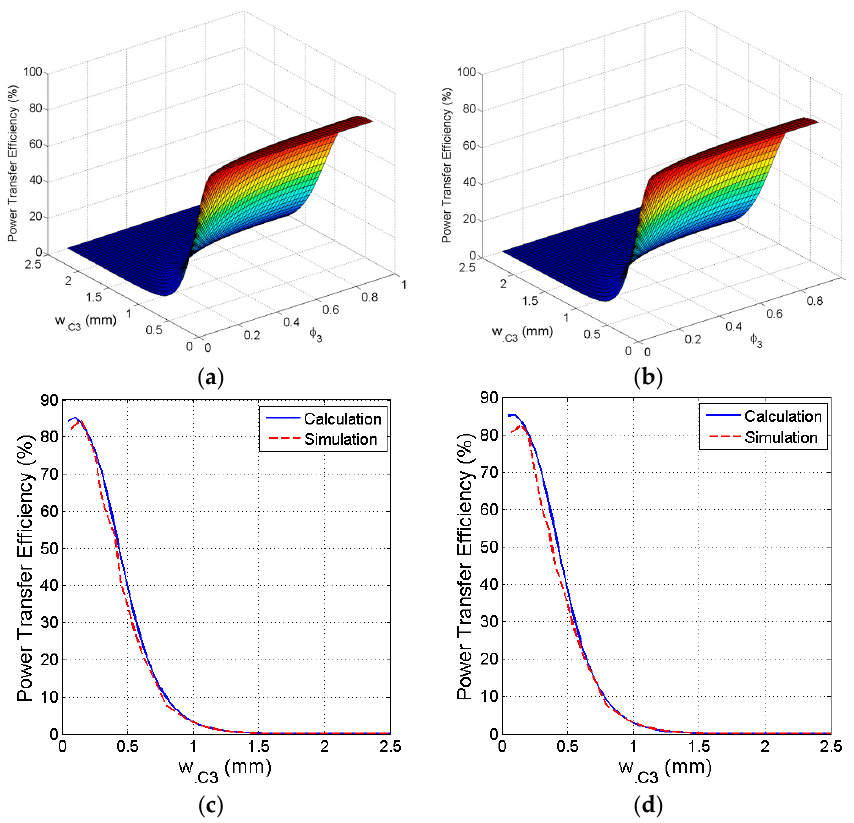
Figure 10. Optimization of the trace line width and fill factor of the secondary PSC. ( a ) Efficiency versus line width versus fill factor of the square coil; ( b ) Efficiency versus line width versus fill factor of the circular coil; ( c ) Calculated and simulated efficiency versus line width of the square coil; ( d ) Calculated and simulated efficiency versus line width of the circular coil.